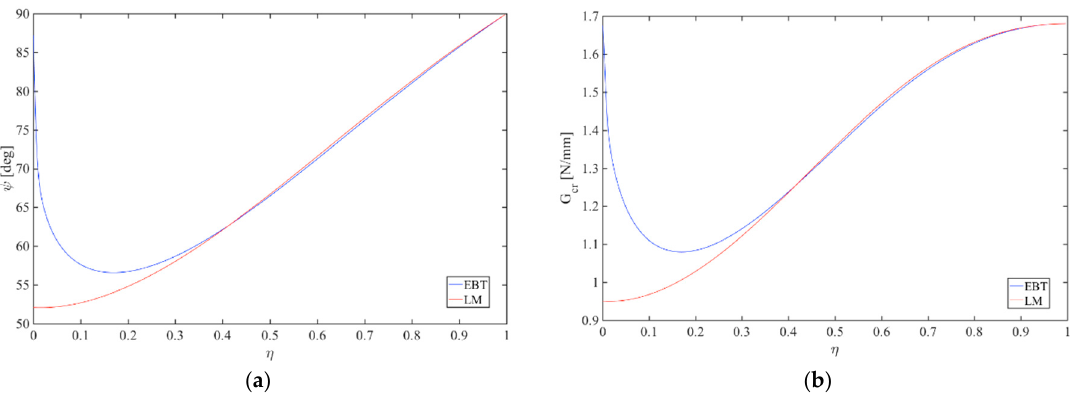
η on the ( a ) Mode-mixity angle